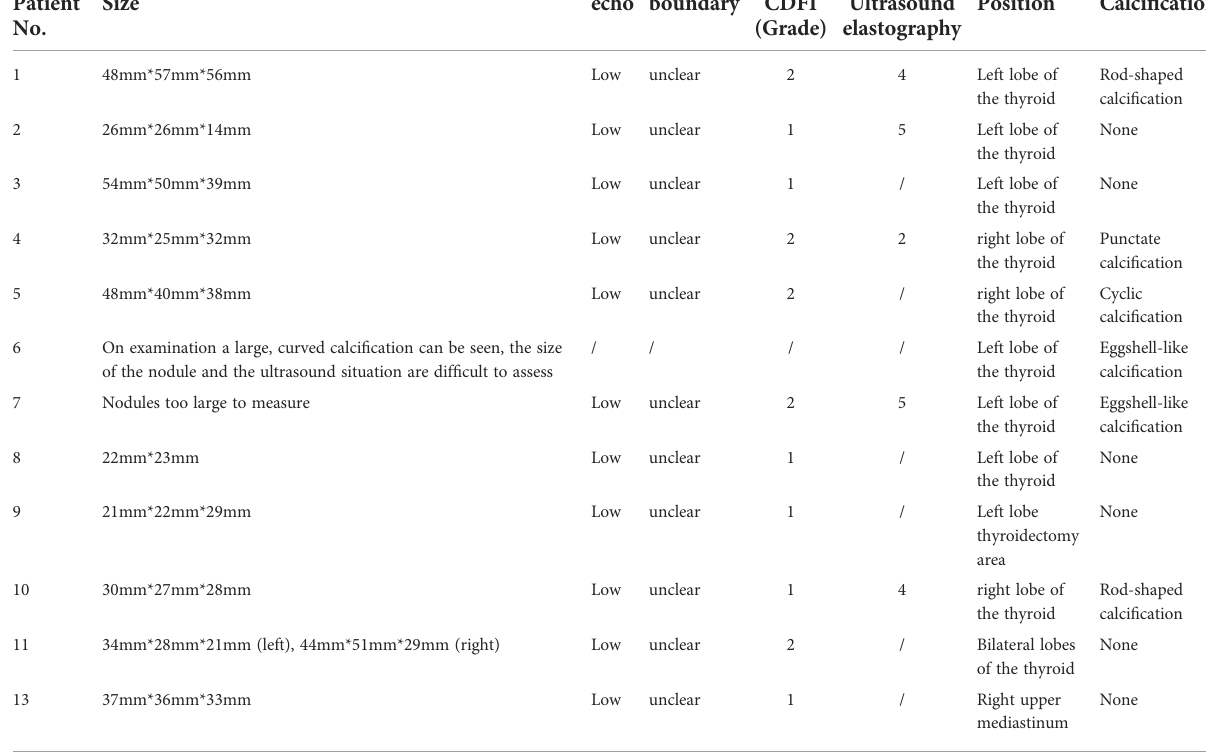
TABLE 2 Ultrasonographic manifestations of